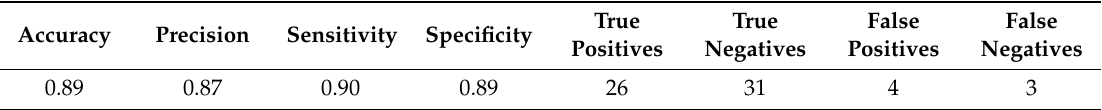
Table 1. Results of Principal Component Analysis-Linear Discriminant Analysis (PCS-LDA) analysis performed on all SER spectra.